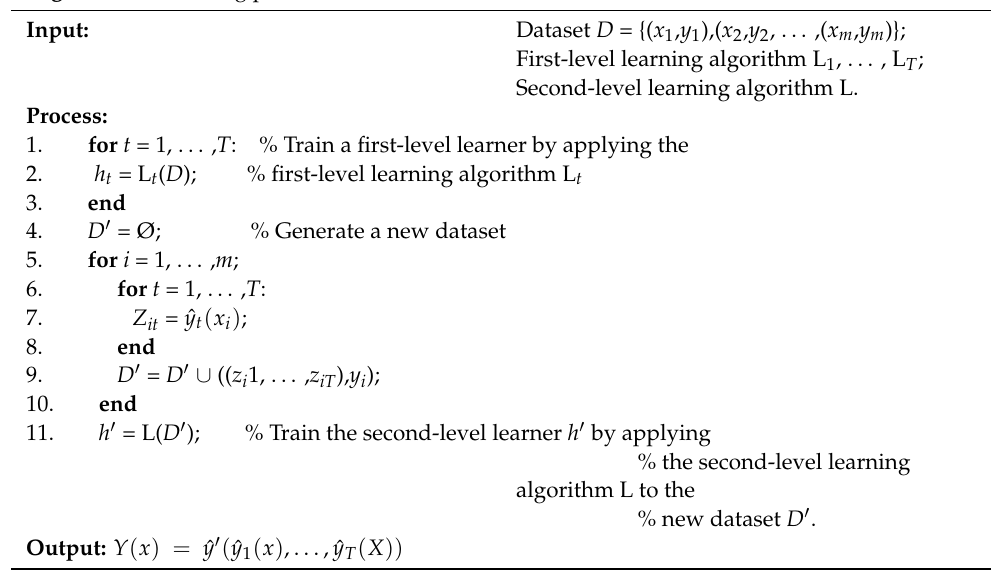
Algorithm 1 . Stacking procedure